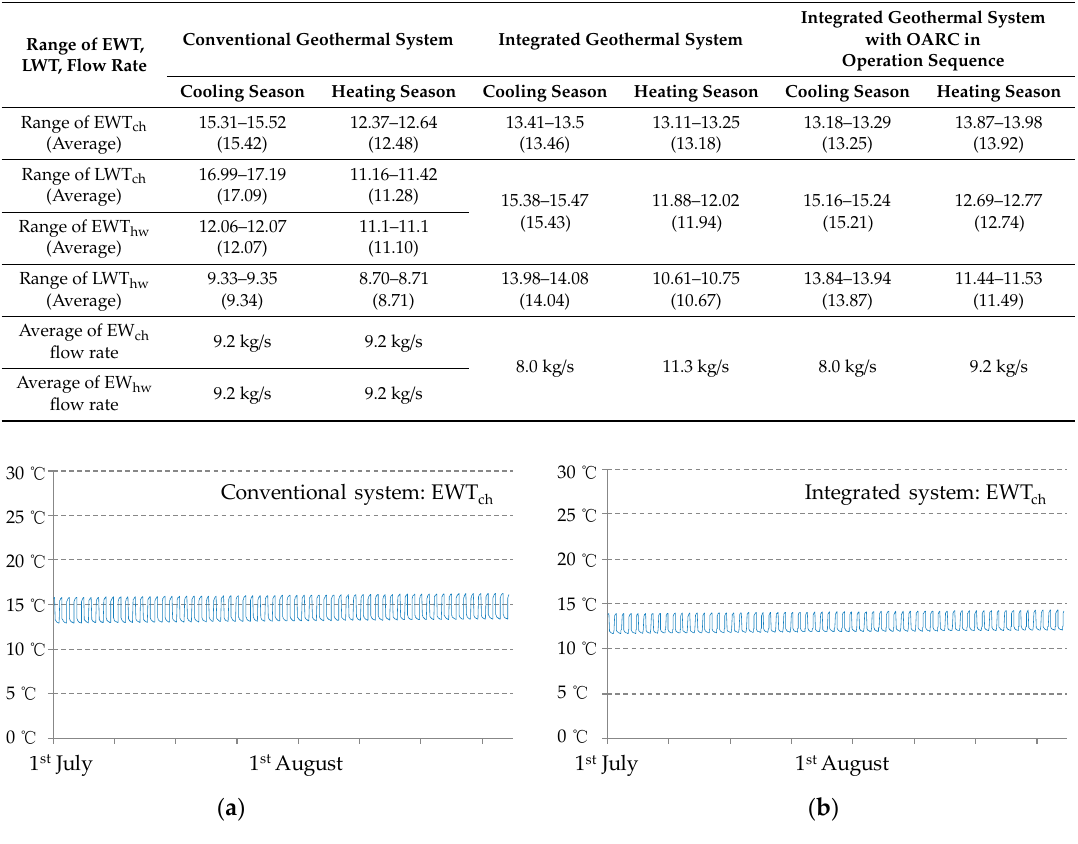
Table 4 . Ranges and averages of EWTs and LWTs entering water flow rates (unit: ° C). Range of EWT, LWT,